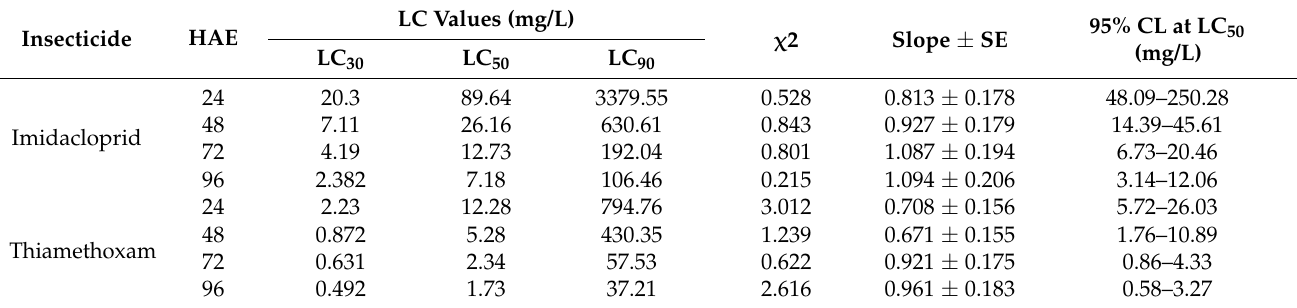
Figure 2. Concentration mortality response of thiamethoxam against whitefly adults. The straight line represents the best fitting probit regression line between insecticide log dose and mortality probits (working probits) for adult B. tabaci at different intervals of time after the insecticide exposure, slopes of the lines are given in the Table 2. The arched line represents the standard error (SE) for the slope of straight regression line. Table 2. Toxicity of imidacloprid and thiamethoxam against whitefly.